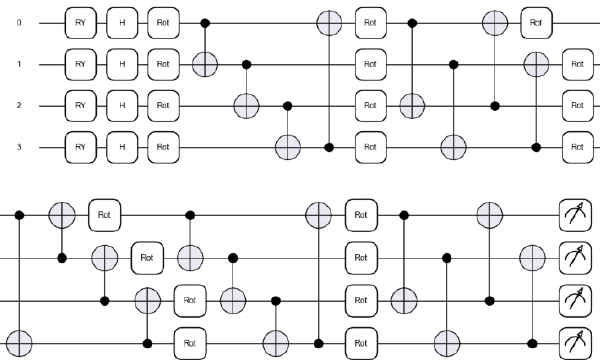
Figure 2. The quantum circuit architecture of the proposed NNQE Circuit model with 5 layers.